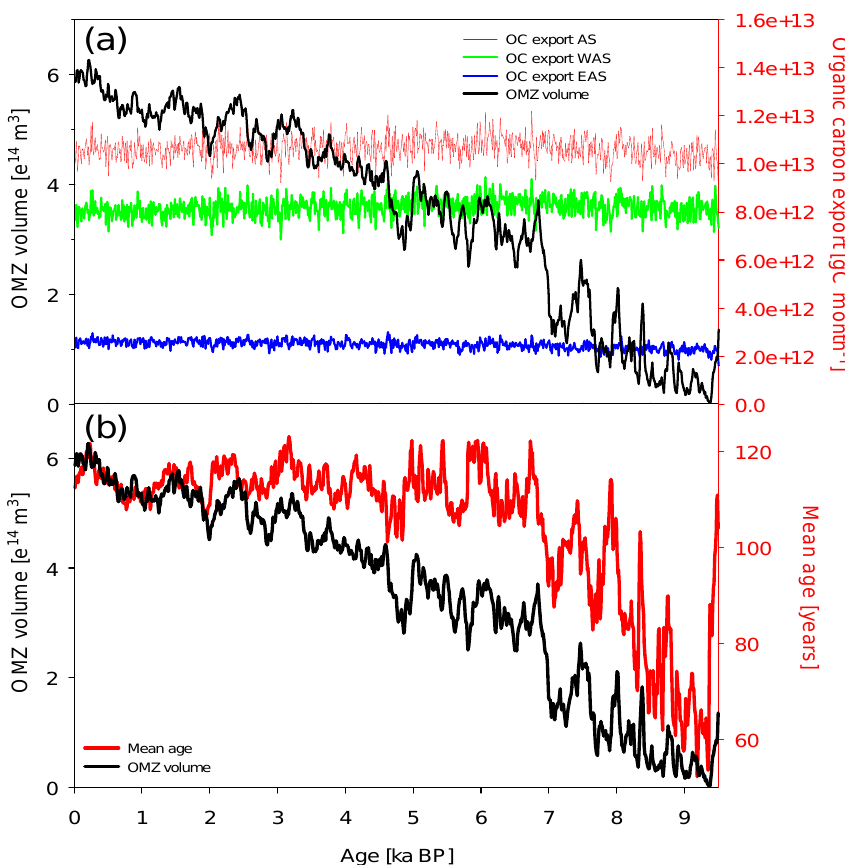
Figure 8. Simulated volume of the Arabian Sea OMZ (70µmolL − 1 threshold, black) and export production in the entire Arabian Sea (red), western Arabian Sea (green) and eastern Arabian Sea (blue) over the Holocene (a) . OMZ volume and age of water masses (time since contact with the surface) averaged over the OMZ (b) . Arabian Sea defined as 55–75 ◦ E, 8.5–22.5 ◦ N; border between west and east defined at 68.5 ◦